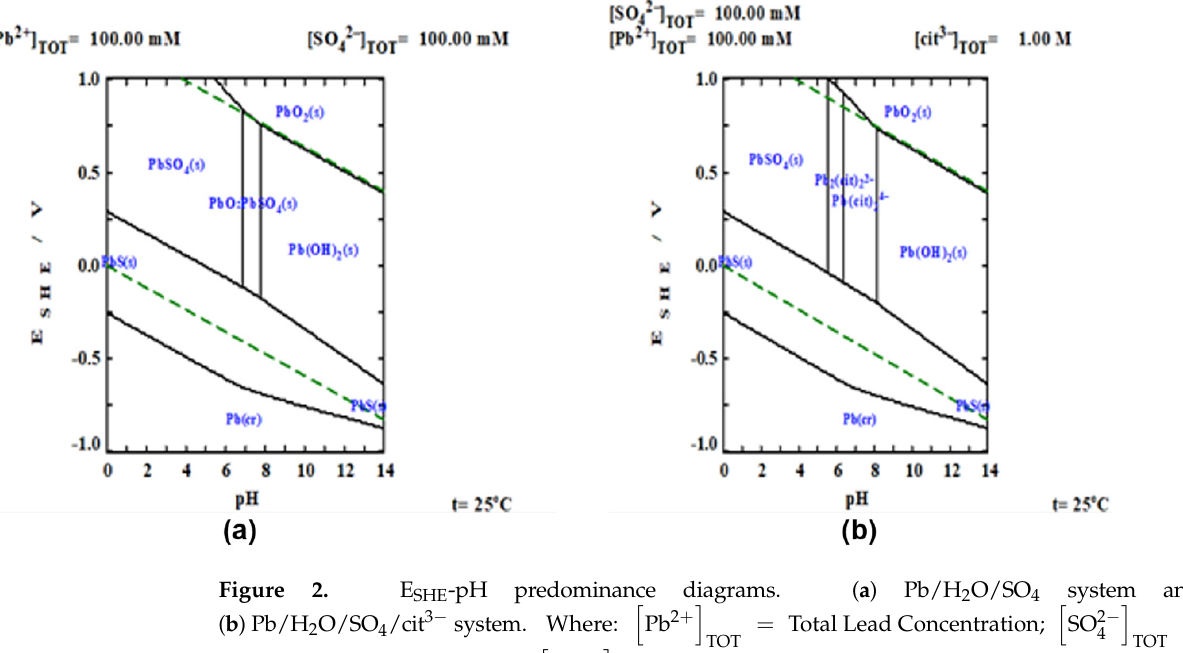
𝑂/𝑆𝑂 / (cid:2870) (cid:2872)